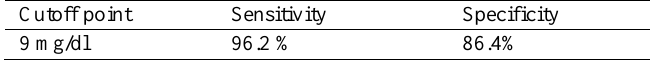
Table (9): Coordinates of the Curve of transcutaneous chest bilirubin regarding jaundice.